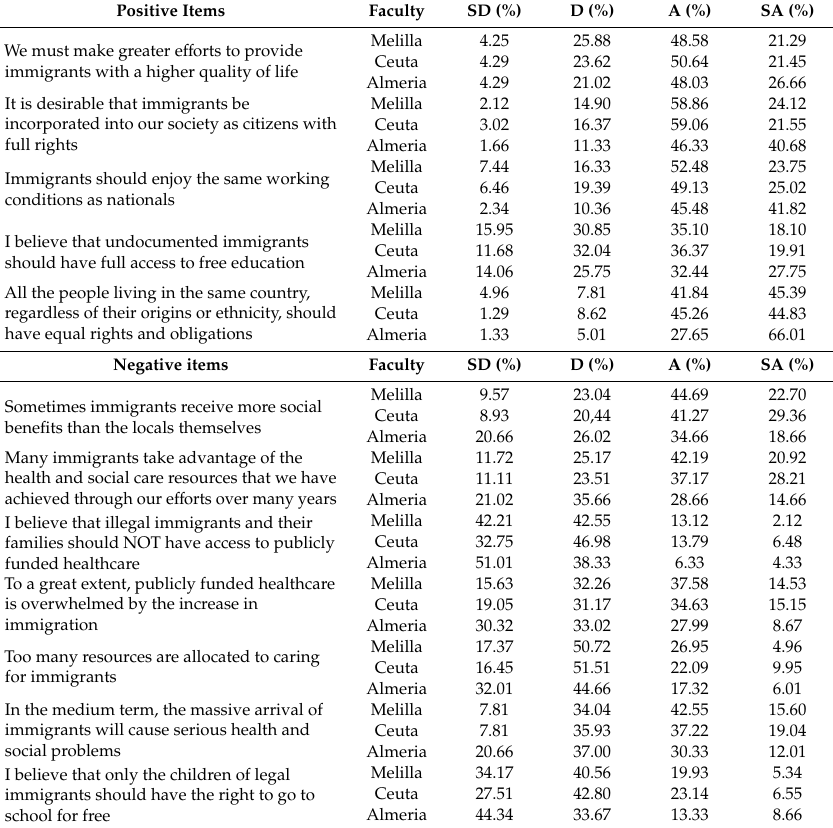
Table 1. Percentages for the answers of the subscale “immigration and social rights”.